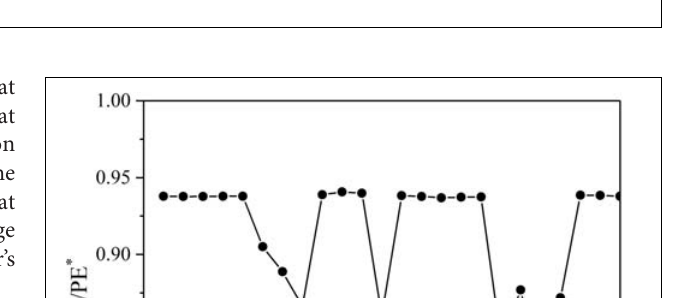
FIGURE 4 | Power supply on a typical winter day.